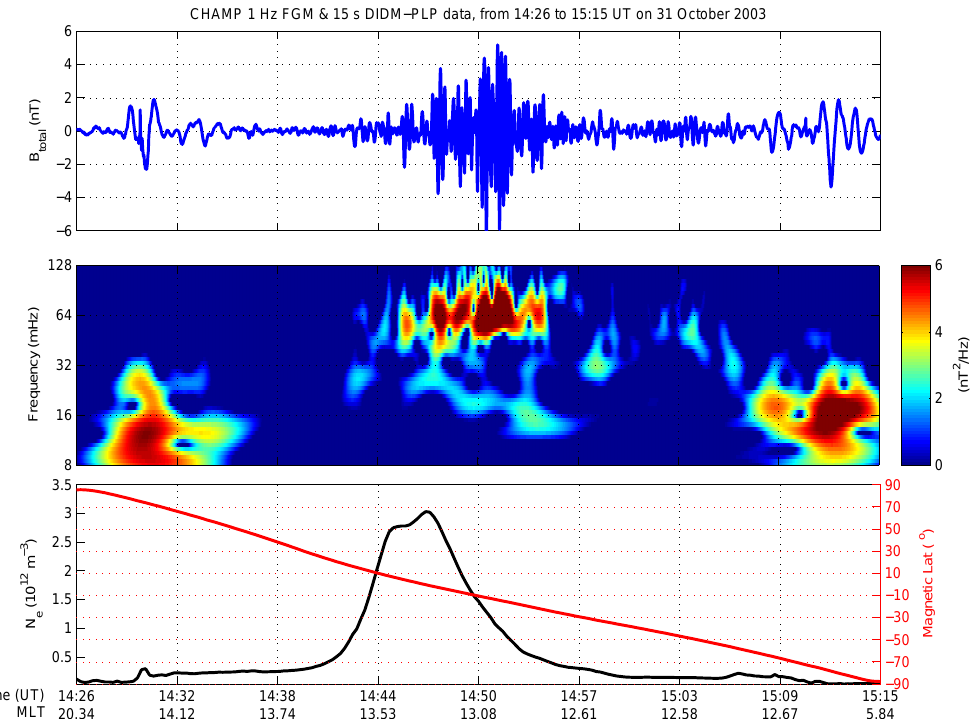
Fig. 4. The CHAMP track from 14:26 to 15:15UT on 31 October 2003. From top to bottom are shown the time series of the CHAMP total magnetic field, calculated from the 1Hz FGM data after applying a 16mHz high-pass filter, its corresponding wavelet power spectrum as well as the temporal variation of the CHAMP electron density data along with its magnetic latitudinal dependence indicating that the satellite was moving from the north to the south pole. The corresponding MLT values are also given at the bottom of the graph. A prominent Pc3 ULF wave is observed starting at around 14:44UT and lasting ∼ 15min. The strong ionospheric currents’ signatures near the poles covering lower frequencies can also be seen in this